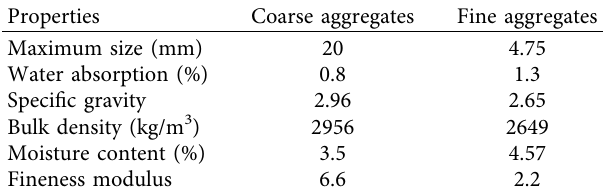
Table 1: Properties of aggregates used in the study.